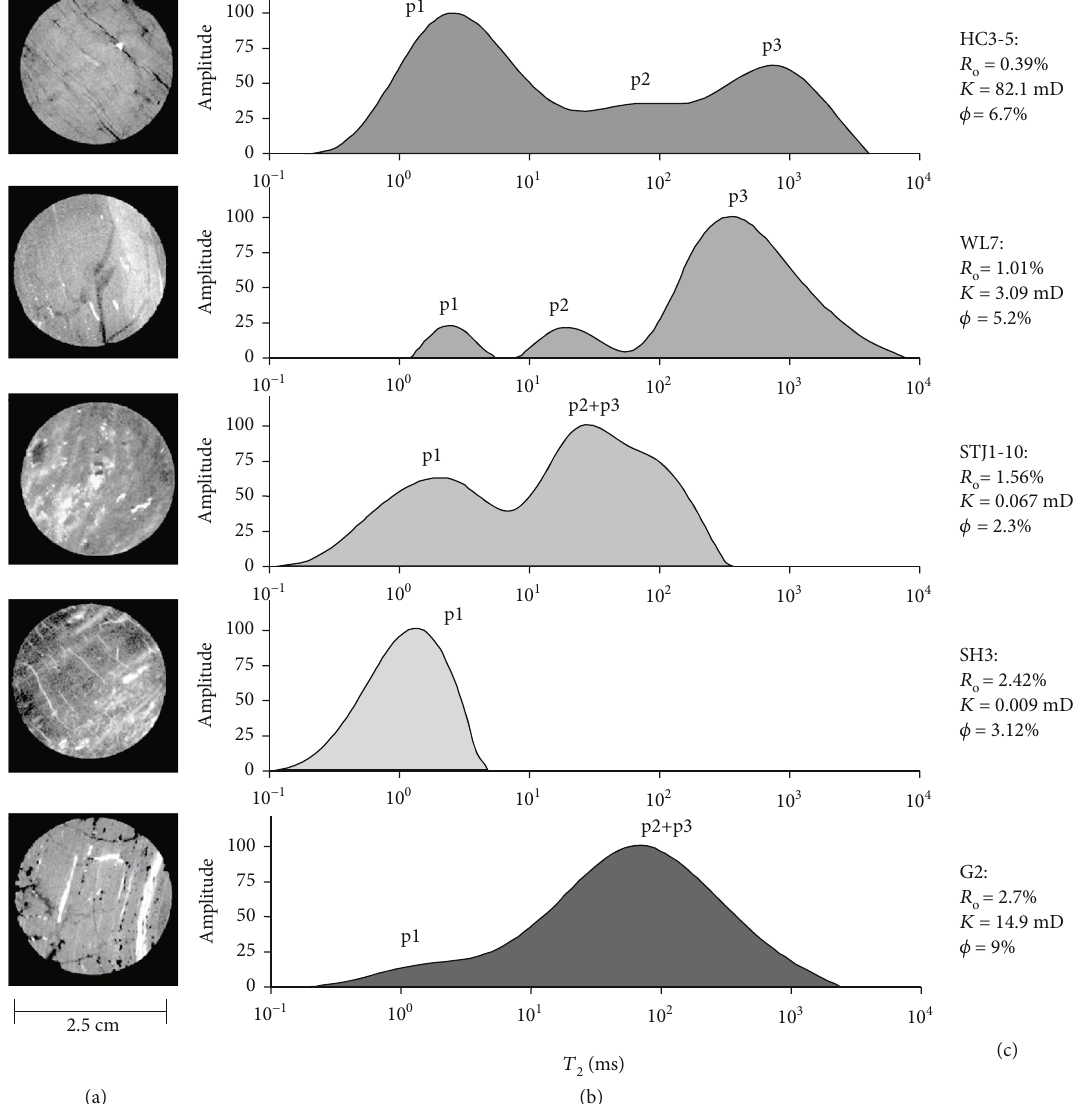
Figure 5: CT scanning images and NMR T distribution showing the pore-fracture characteristics and pore size distribution of di ff erently 2 ranked coals (modi fi ed from Yao et al.